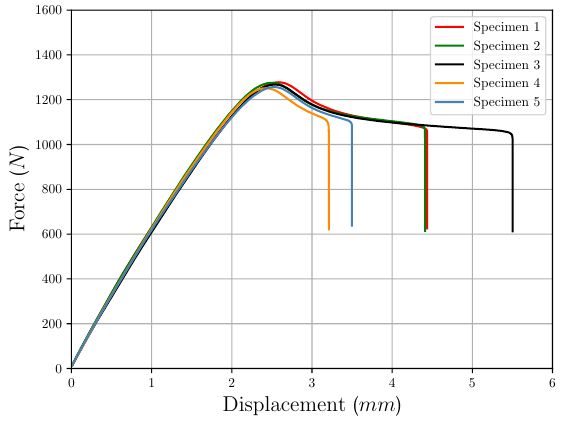
Figure 5. Experimental results.